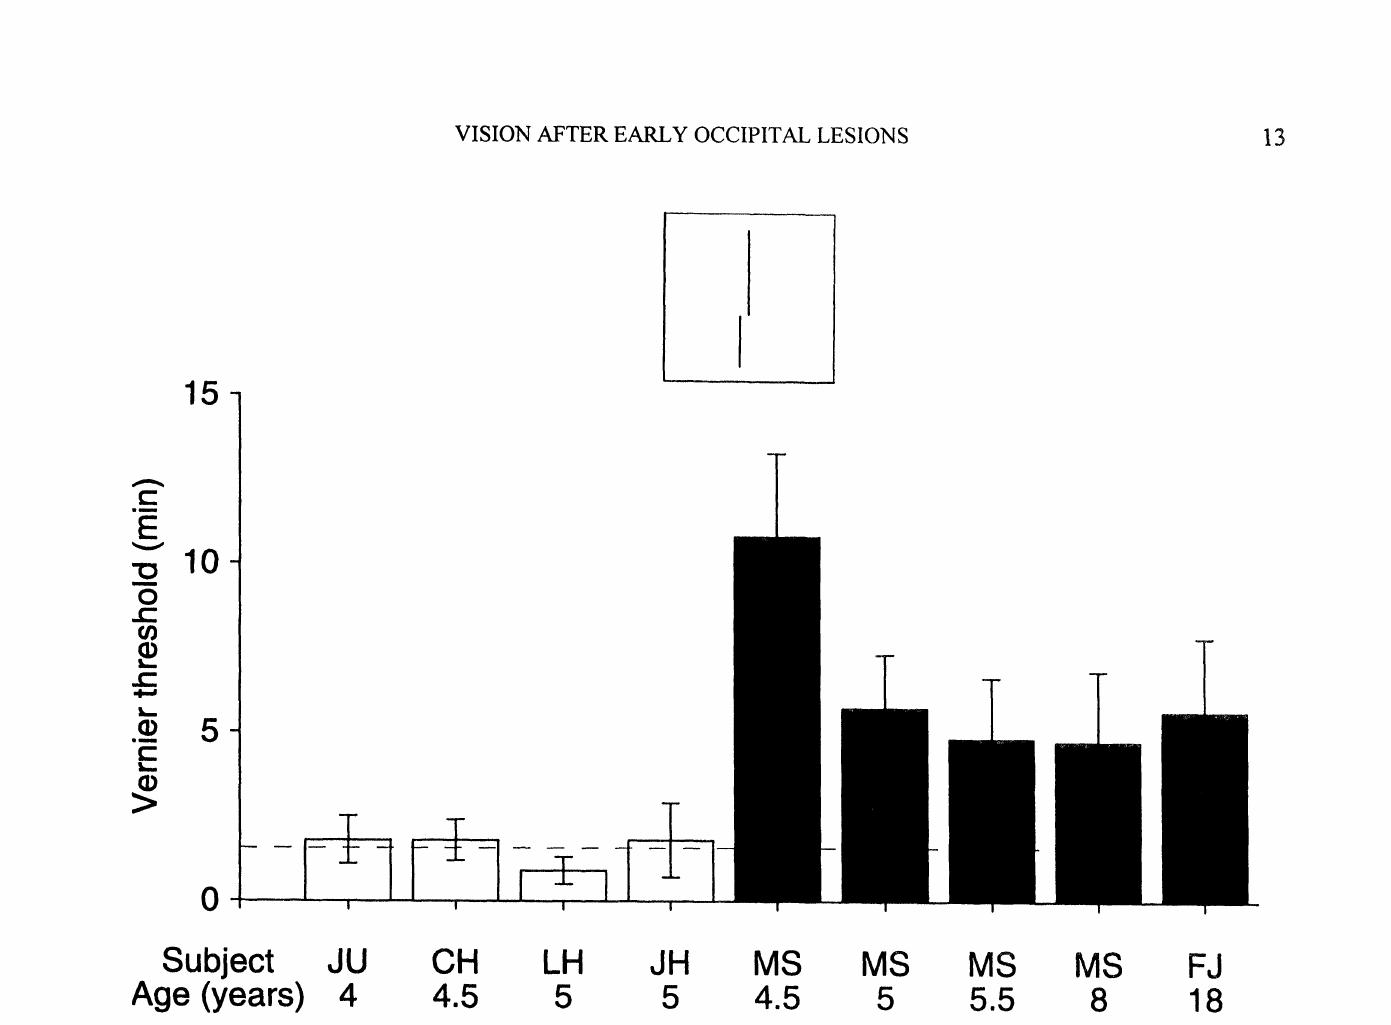
Fig. 4: (A) Vemier offset thresholds for MS at four different ages compared with those of FJ (age 18) and normal children. The error bars show the SE for the threshold estimates. The inset above the graph shows the stimulus configuration for that experiment. The subject’s task was to decide whether the lower line segment was aligned with the upper segment and to indicate whether it was displaced to the left or to the